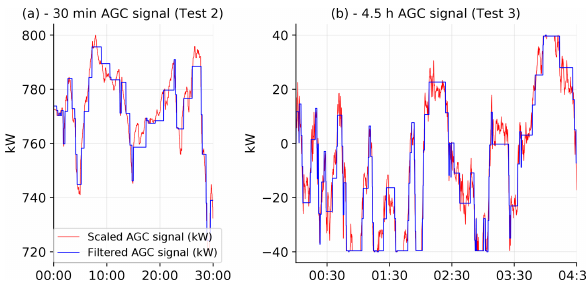
Figure 5. Scaled AGC signals (red) and result of applying a differ- ential magnitude filter